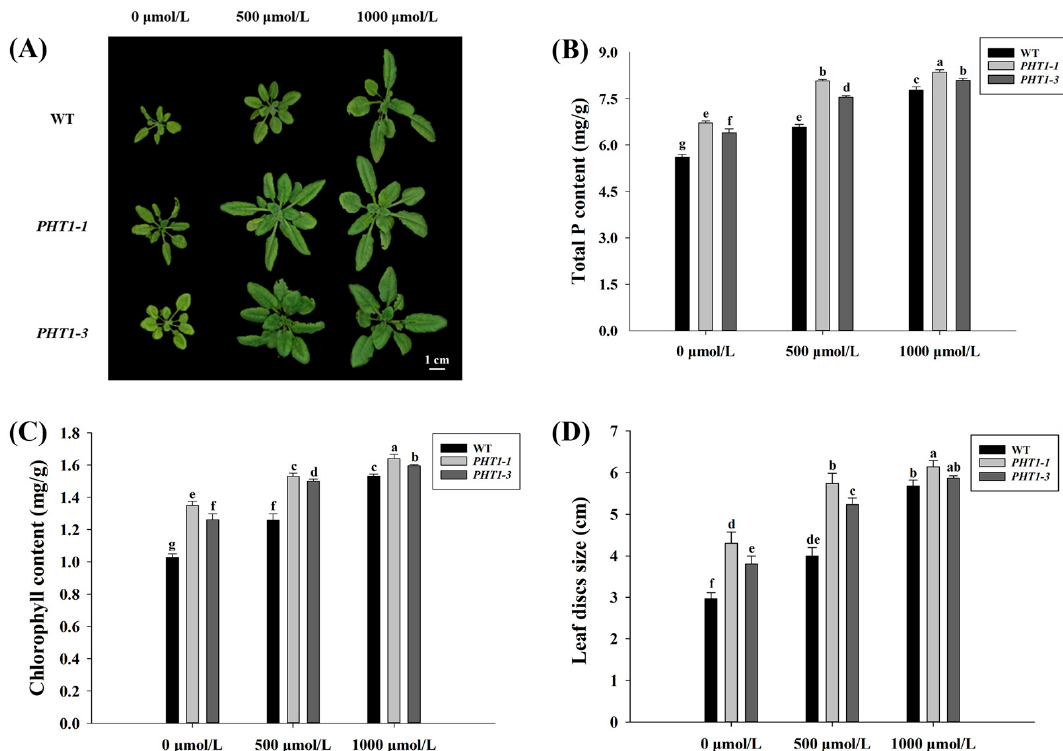
Figure 7. Growth status of wt and PTH1s transgenic Arabidopsis plants, including ( A ) phenotype, ( B ) total P content, ( C ) chlorophyll content, and ( D ) leaf disc size. The treatments included: zero P treatment (0 µ mol/L), low P treatment (500 µ mol/L), and normal P treatment (1000 µ mol/L). Columns marked with different lowercase letters indicate significant differences ( p < 0.05) between genotypes. Error bars represent the standard error of means ( n = 3).